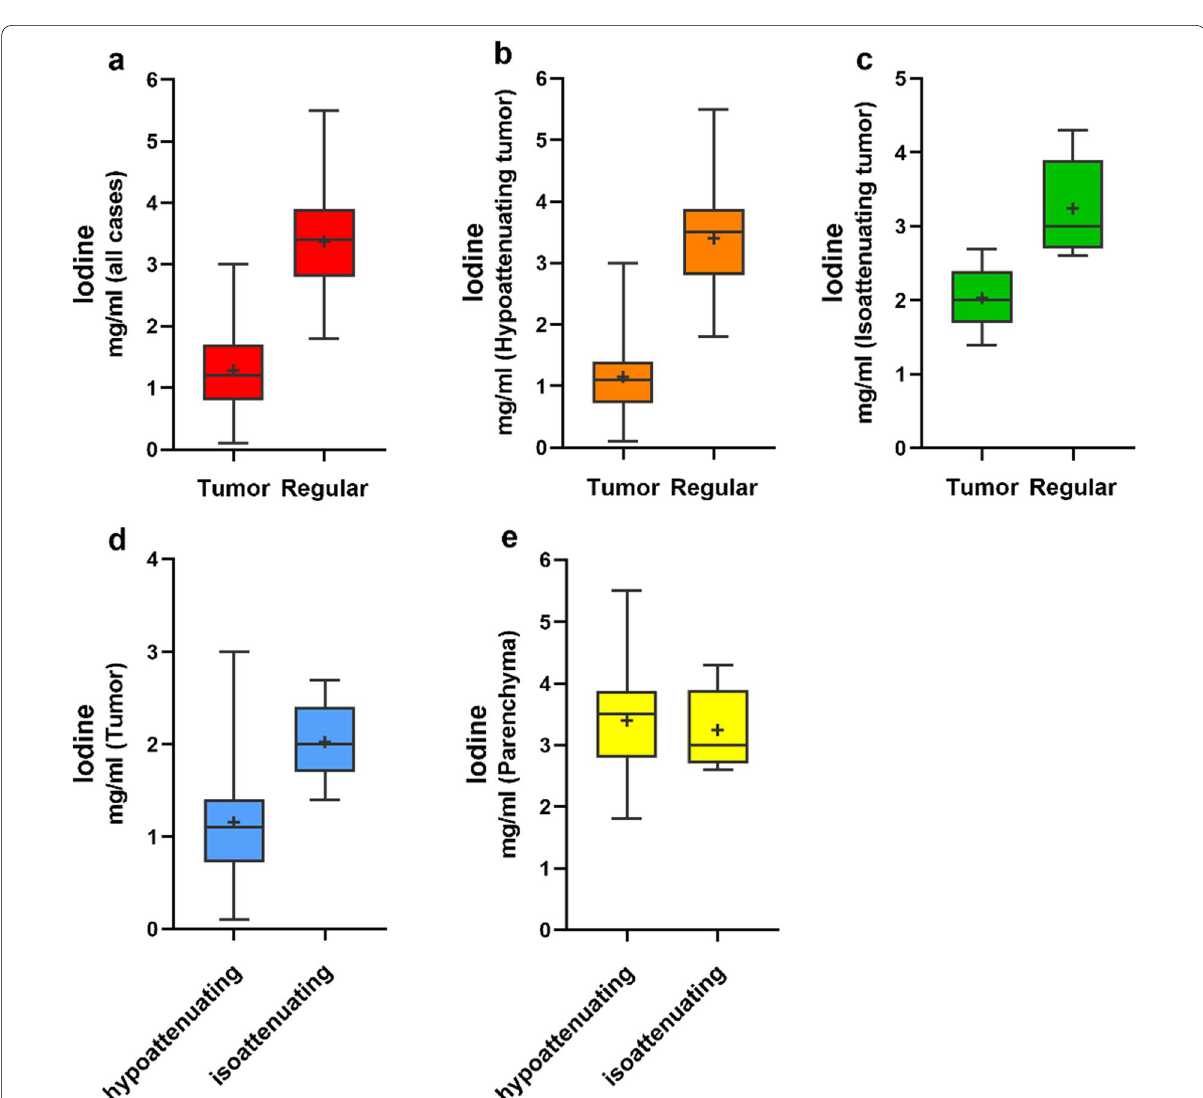
Fig. 3 Normalized iodine concentration (NIC) was calculated and compared between tumor and regular pancreatic parenchyma ( a – c ). In panel d , e , the NIC between the visually hypoattenuating and isoattenuating pancreatic ductal adenocarcinoma (PDAC) is depicted. Box shows the 25‑and 75‑quartile, and horizontal line represents median value, and the cross indicates average